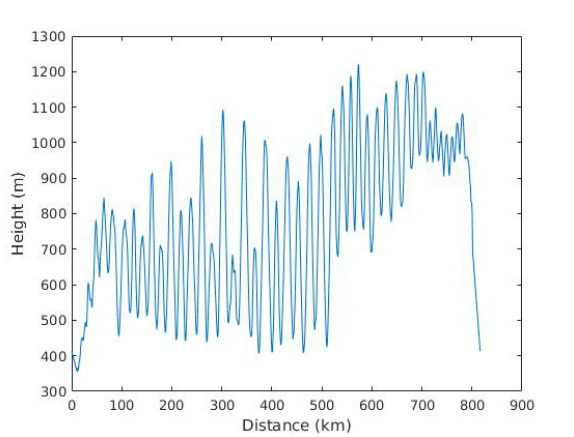
Figure 11. Height variation versus mission distance.